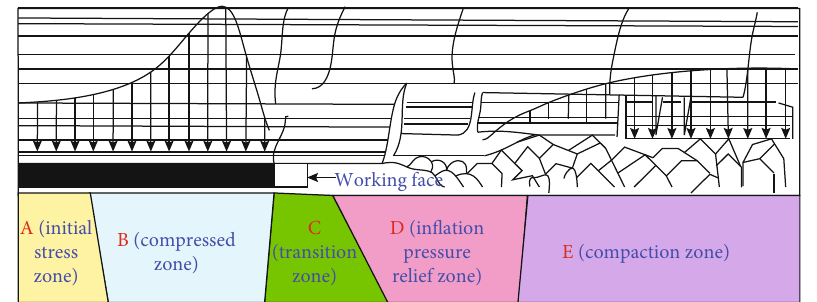
Figure 1: Simulated diagram of the coal seam fl oor failure.